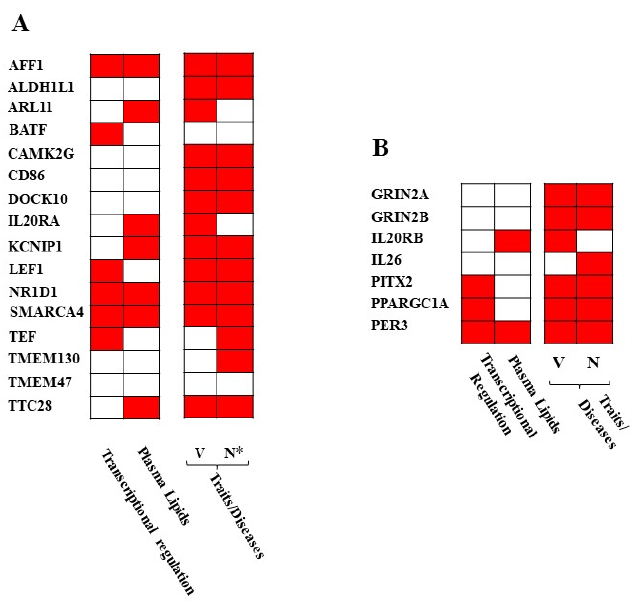
Figure 4. Association of GWAS ( A ) and interactor ( B ) genes and their encoded mRNA/proteins with transcription, and with vascular (V)/neuronal (N) traits or diseases according to literature and databases. N*, neuronal diseases additional to MS. Associations of ncRNAs (LINC01108 and LOC00130476) with diseases were not found in literature and databases.